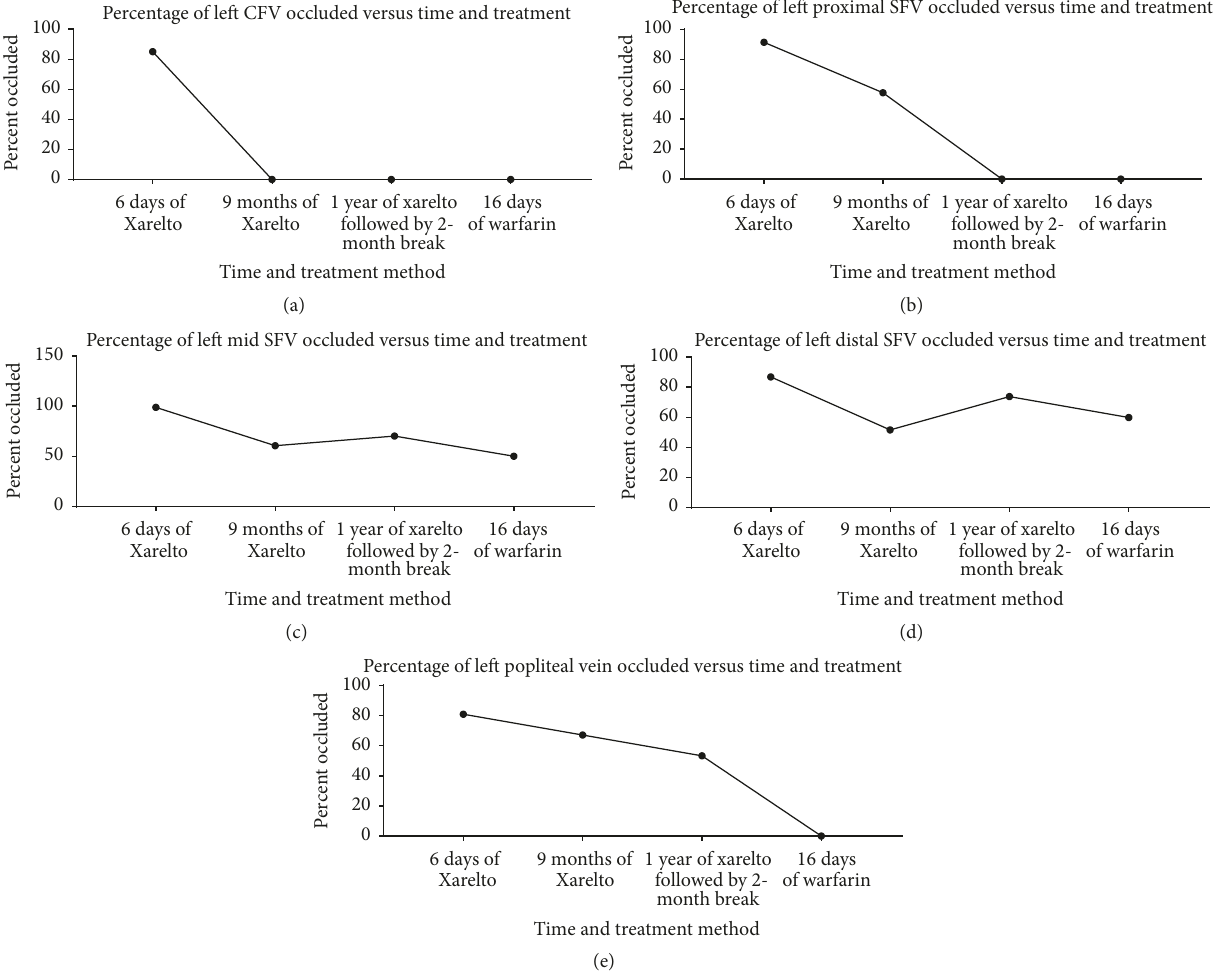
Figure 2: Left lower extremity vein percent occlusion. (a) Progression of vein occlusion of left CFV. (b) Progression of vein occlusion of left proximal SFV. (c) Progression of vein occlusion of left mid-SFV. (d) Progression of vein occlusion of left distal SFV. (e) Progression of vein occlusion of left popliteal